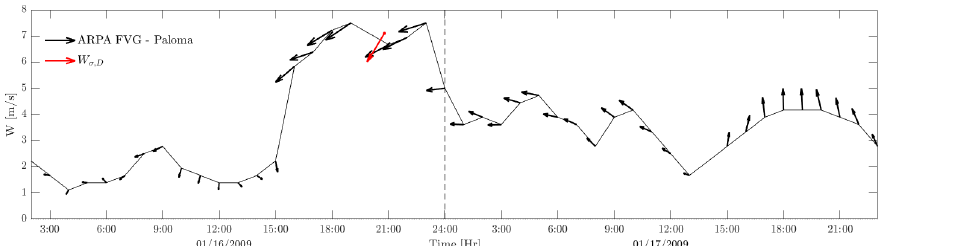
Figure 7. Wind measured by ARPA FVG-OSMER e GRN Paloma buoy [57] at 5 m.s.l. The red vector represents W σ , D at the same coordinates and its module correspond to 7.1